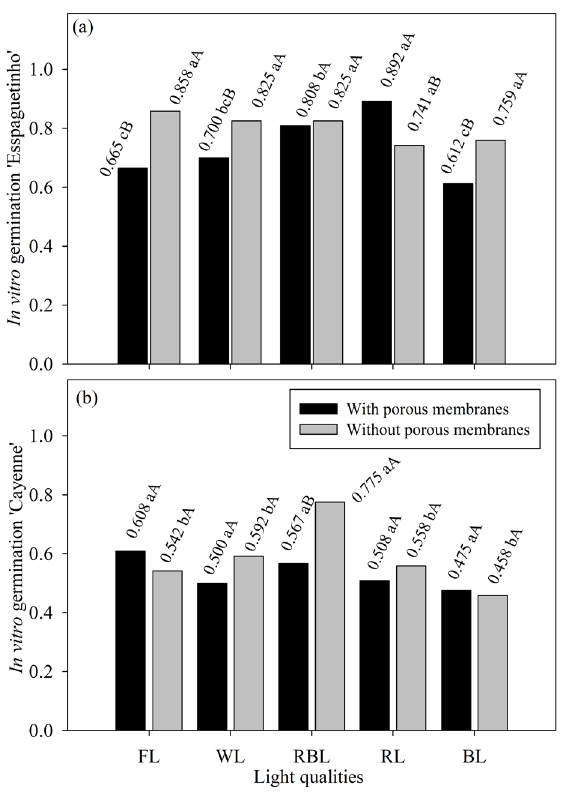
Figure 2. In vitro germination of Capsicum frutescens cv. Espaguetinho (a) and Cayenne (b) , evaluated after 42 days of culture under different light qualities and types of sealing. *Lowercase letters in type of sealing (with or without membrane), and uppercase letters in the same light quality do not differ by the Tukey’s test at 5%